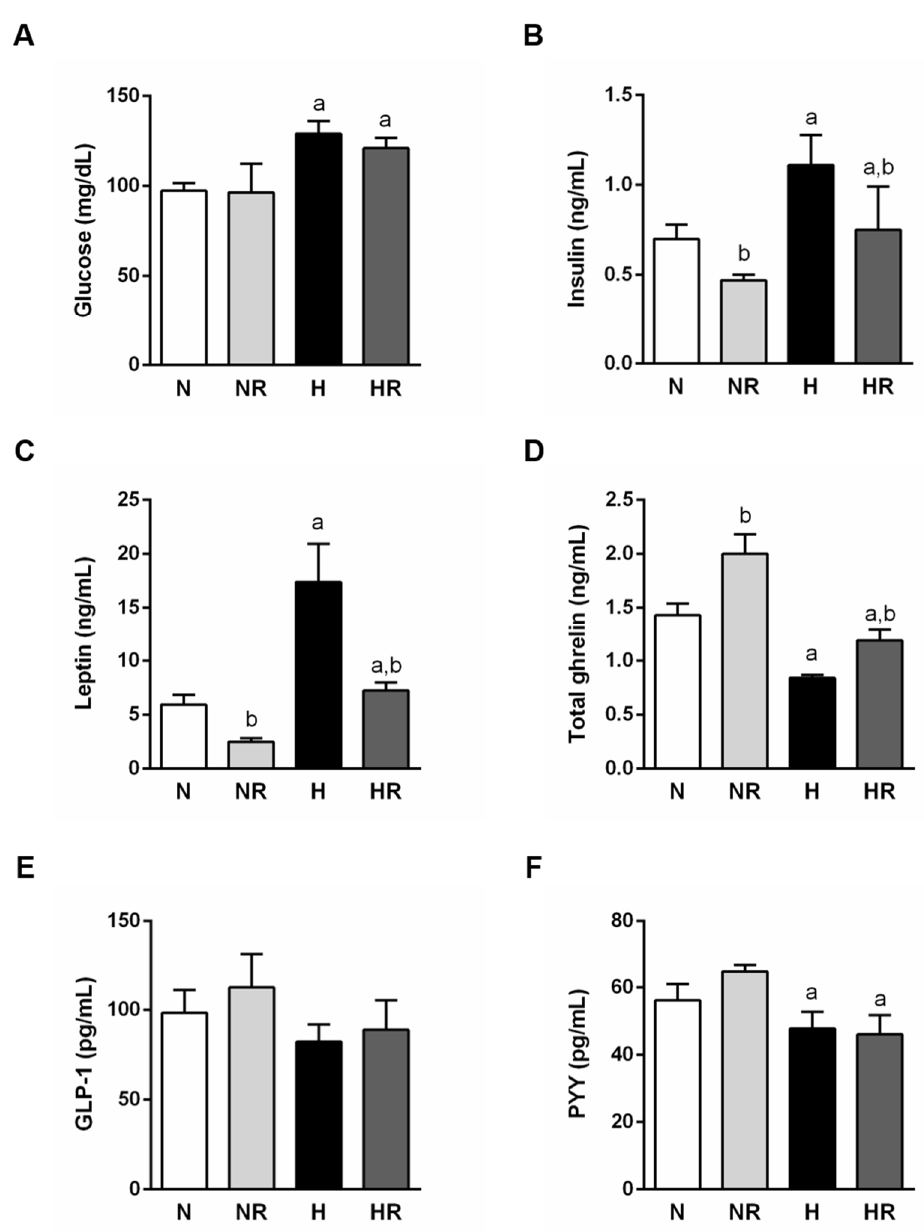
( p = 0.266) (Figure 4C) and ghrelinemia ( p = 0.196) (Figure 4D), but different serum PYY levels, which were higher in the N group ( p < 0.05) (Figure 4F).